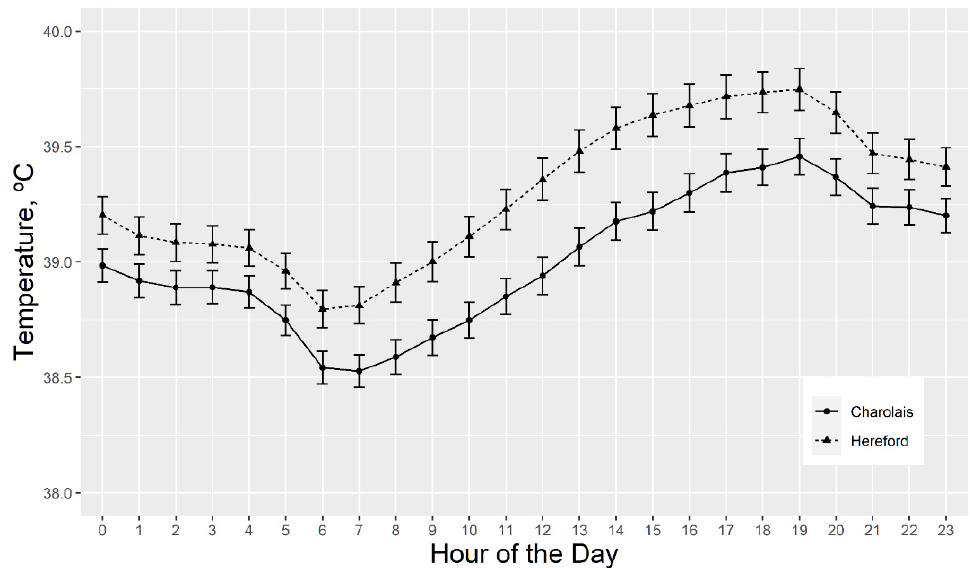
Figure 5. Least square means for repeated measures of vaginal temperatures for Charolais- and Hereford-sired cows, regardless of fescue treatment type. The last week of the trial, after cows had grazed either toxic or novel fescue for 5 months, cow vaginal temperatures were recorded using iButton thermosensors (Digi-Key, Thief River Falls, MN, USA) in progesterone-free Controlled Internal Drug Releasing Device (CIDR) (Zoetis Parsippany-Troy, NJ, USA). Temperatures were captured every 5 min at a sensitivity of ±0.5 °C. Six days of temperatures were analyzed to exclude handling bias. Significant breed effect on vaginal temperature, by hour at p ≤ 0.05, is indicated, where error bars do not overlap.